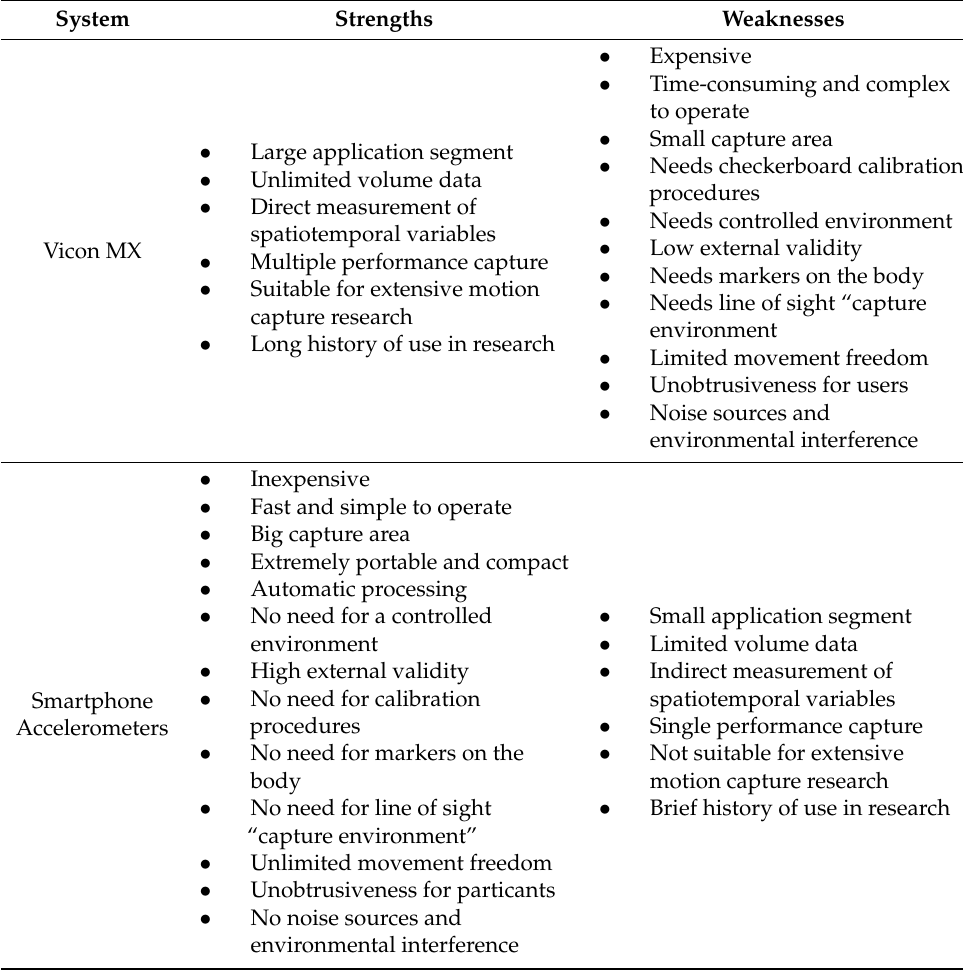
Table 7. Strengths and weaknesses of the study’s motion capture